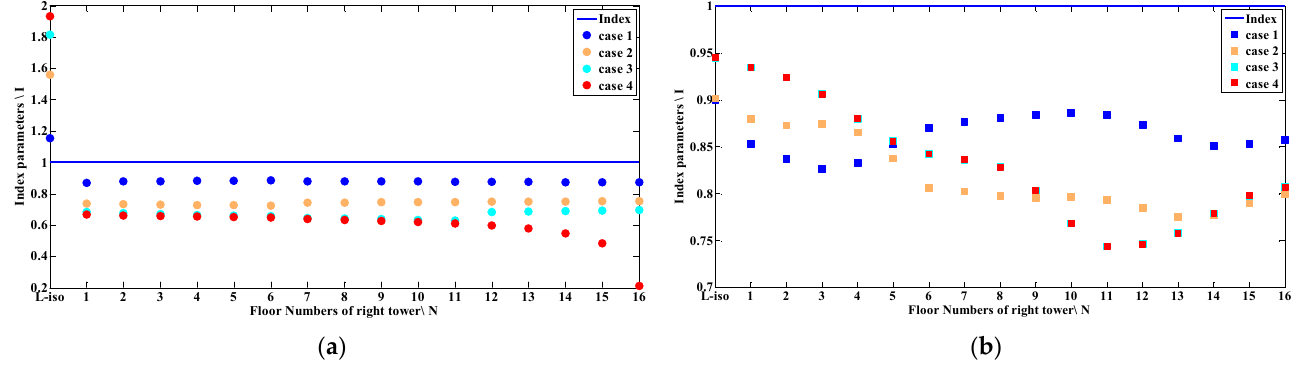
Figure 17. ( a ) Control effect of displacement response of right tower; ( b ) control effect of absolute acceleration response of right tower .